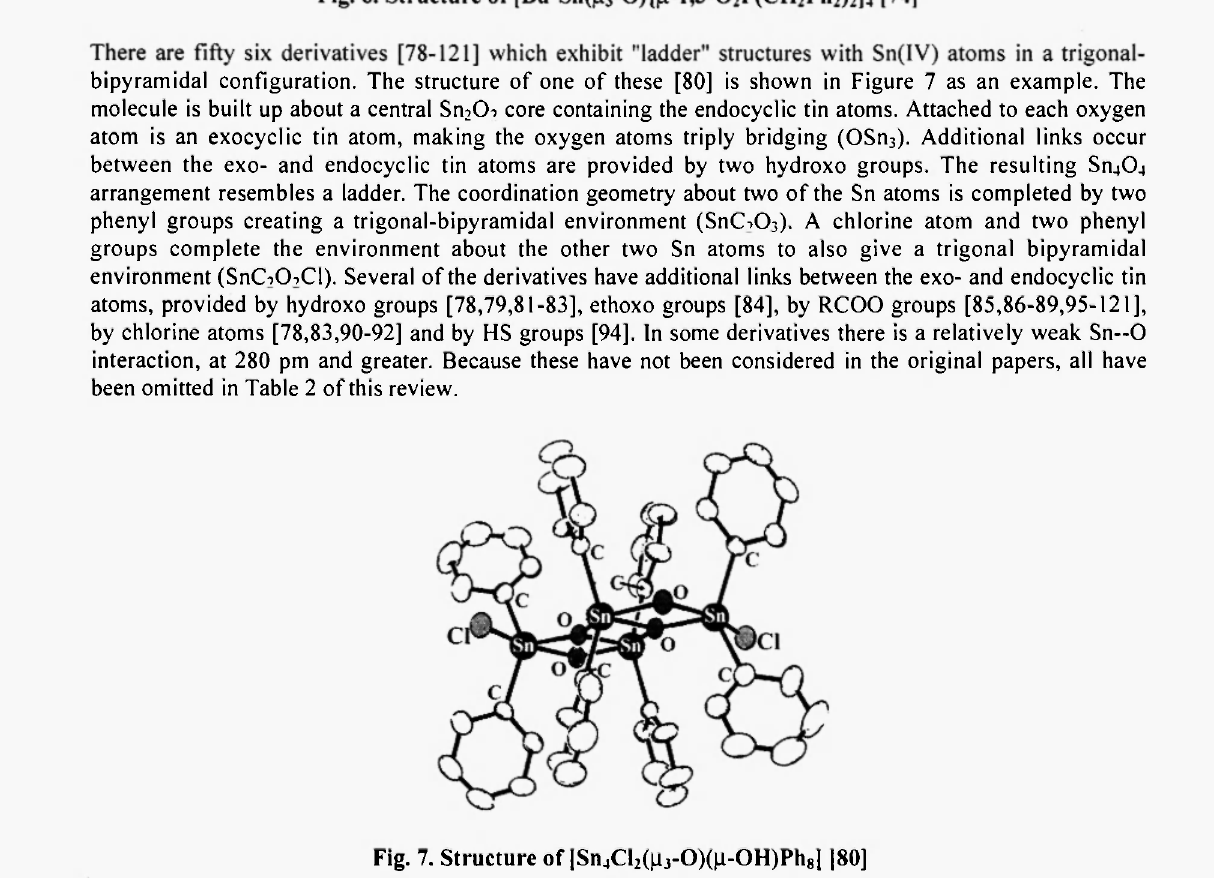
Fig. 7. Structure of |8η 4 α 2 (μ 3 -0 )(μ -0Η)ΡΙι 8 |